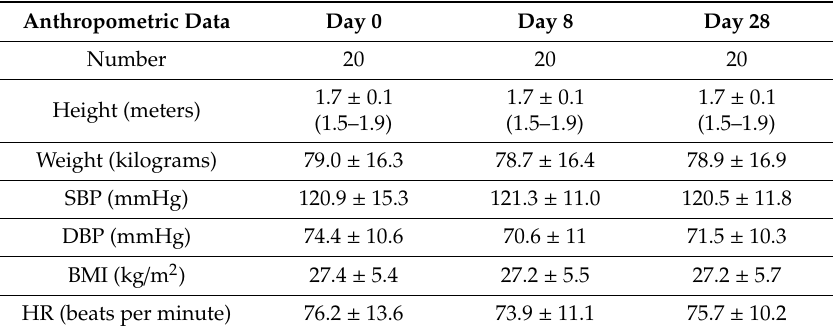
Table 1. Anthropometric and clinical characteristics of